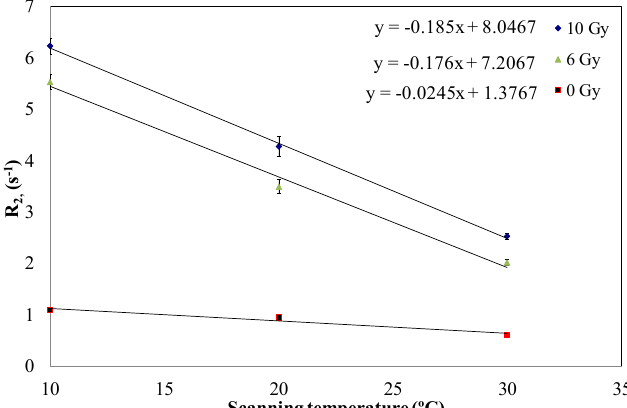
Figure 6. Relaxation rate of unirradiated and irradiated gels with 500 mM CaCl 2 exposed to 6 and 10 Gy as a function of scanning temperature. Error bars are the 2 σ of R 2 values.